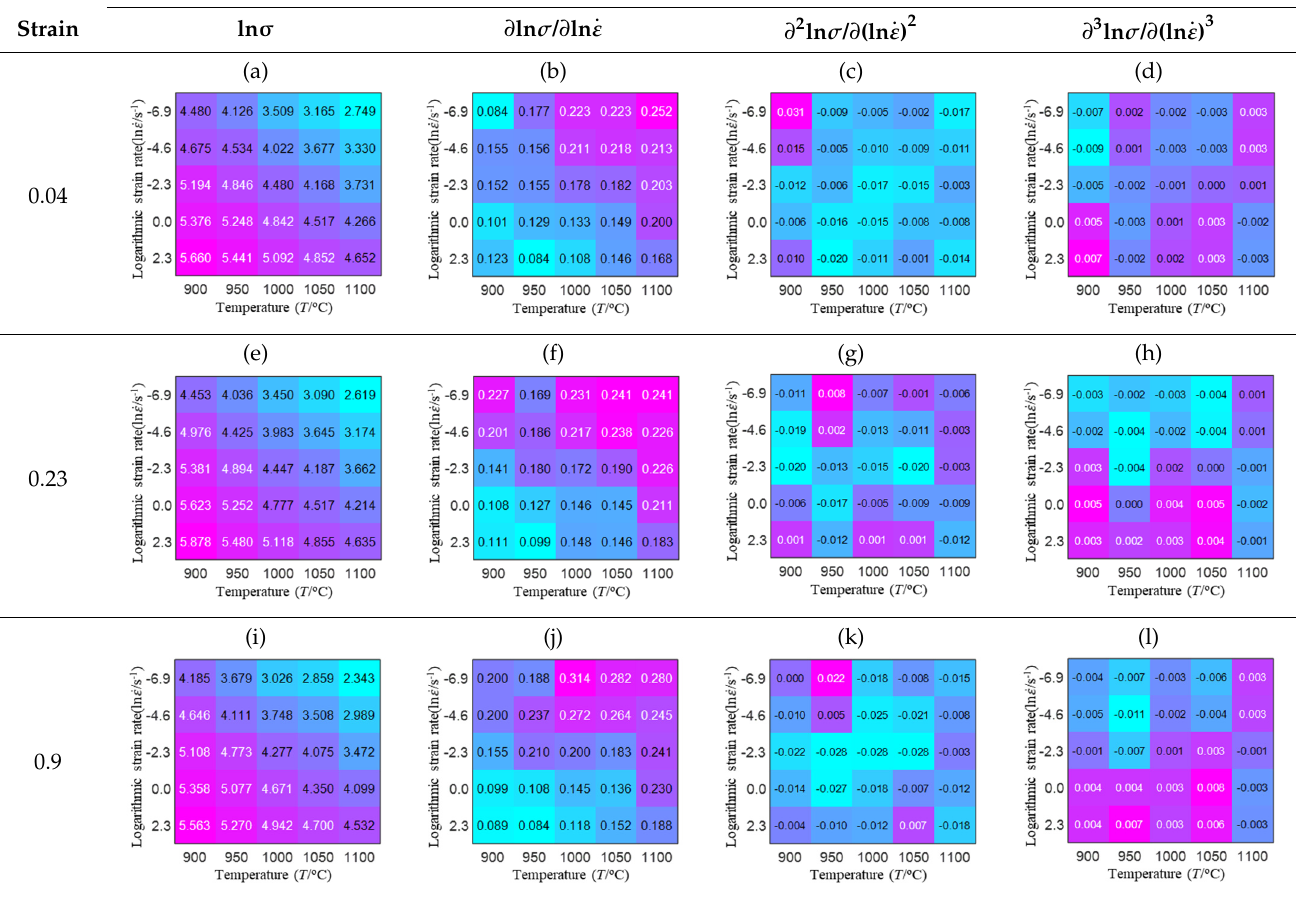
accuracy. accuracy. Table 6. The first, second and third partial derivatives of logarithmic stress with respect to the var- Table 6. The first, second and third partial derivatives of logarithmic stress with respect to the var- Table 6. The first, second and third partial derivatives of logarithmic stress with respect to the var- Table 6. The first, second and third partial derivatives of logarithmic stress with respect to the var- iable logarithmic strain rate at low ( 𝜀 = 0.04 ), medium ( 𝜀 = 0.23 ) and high ( 𝜀 = 0.90 ) strain levels iable logarithmic strain rate at low ( 𝜀 = 0.04 ), medium ( 𝜀 = 0.23 ) and high ( 𝜀 = 0.90 ) strain levels iable logarithmic strain rate at low ( 𝜀 = 0.04 ), medium ( 𝜀 = 0.23 ) and high ( 𝜀 = 0.90 ) strain levels iable logarithmic strain rate at low ( 𝜀 = 0.04 ), medium ( 𝜀 = 0.23 ) and high ( 𝜀 = 0.90 ) strain levels for experiment flow stress Table 6. The first, second and third partial derivatives of logarithmic stress with respect to the var- for experiment flow stress curves. for experiment flow stress curves. for experiment flow stress curves. Table 6. The first, second and third partial derivatives of logarithmic stress with respect to the var- Table 6. The first, second and third partial derivatives of logarithmic stress with respect to the var- Table 6. The first, second and third partial derivatives of logarithmic stress with respect to the var- iable logarithmic strain rate at low ( 𝜀 = 0.04 ), medium ( 𝜀 = 0.23 ) and high ( 𝜀 = 0.90 ) strain levels iable logarithmic strain rate at low ( 𝜀 = 0.04 ), medium ( 𝜀 = 0.23 ) and high ( 𝜀 = 0.90 ) strain levels iable logarithmic strain rate at low ( 𝜀 = 0.04 ), medium ( 𝜀 = 0.23 ) and high ( 𝜀 = 0.90 ) strain levels iable logarithmic strain rate at low ( 𝜀 = 0.04 ), medium ( 𝜀 = 0.23 ) and high ( 𝜀 = 0.90 ) strain levels for experiment flow stress curves. for experiment flow stress curves. for experiment flow stress curves. for experiment flow stress curves. Table 6. The first, second and third partial derivatives of logarithmic stress with respect to the var- Table 6. The first, second and third partial derivatives of logarithmic stress with respect to the var- Table 6. The first, second and third partial derivatives of logarithmic stress with respect to the var- Table 6. The first, second and third partial derivatives of logarithmic stress with respect to the var- Table 6. The first, second and third partial derivatives of logarithmic stress with respect to the variable iable logarithmic strain rate at low ( 𝜀 = 0.04 ), medium ( 𝜀 = 0.23 ) and high ( 𝜀 = 0.90 ) strain levels iable logarithmic strain rate at low ( 𝜀 = 0.04 ), medium ( 𝜀 = 0.23 ) and high ( 𝜀 = 0.90 ) strain levels iable logarithmic strain rate at low ( 𝜀 = 0.04 ), medium ( 𝜀 = 0.23 ) and high ( 𝜀 = 0.90 ) strain levels iable logarithmic strain rate at low ( 𝜀 = 0.04 ), medium ( 𝜀 = 0.23 ) and high ( 𝜀 = 0.90 ) strain levels for experiment flow stress curves. for experiment flow stress curves. for experiment flow stress curves. for experiment flow stress curves. logarithmic strain rate at low ( ε = 0.04), medium ( ε = 0.23) and high ( ε = 0.90) strain levels for experiment flow stress curves.